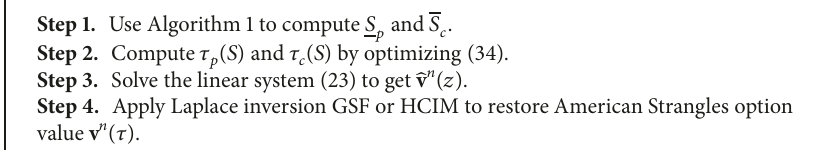
Algorithm 2: NLTM algorithm for pricing American